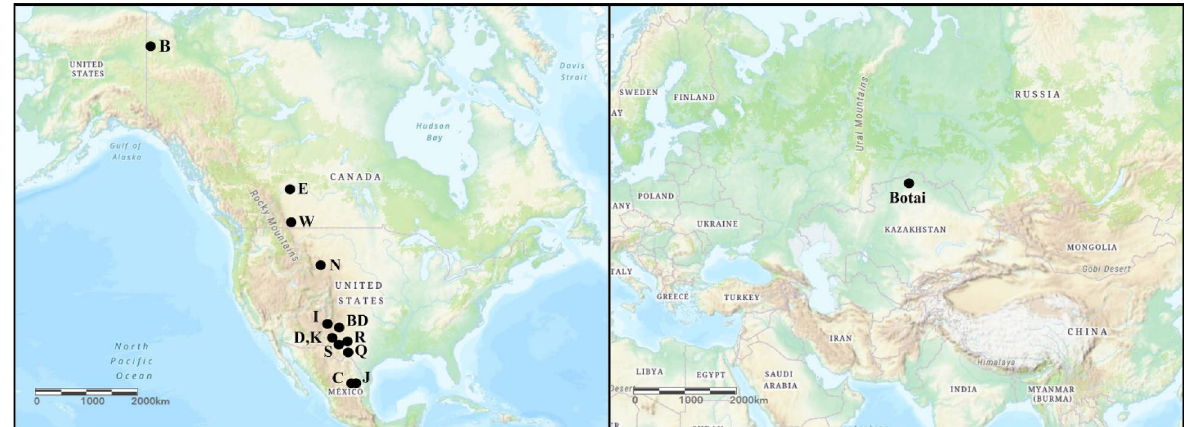
Figure 1. Geographic location of Botai (right) and North American Pleistocene sites (left). Site abbreviations: B = Bluefish Caves, BD = Blackwater Draw Loc. 1, C = Cedral, D = Dry Cave, E = Edmonton area gravel pits, I = Isleta Cave No. 2, J = San Josecito Cave, K = Dark Canyon Cave, N = Natural Trap Cave, Q = Cueva Quebrada, R = Scharbauer Ranch, S = Salt Creek, W = Wally’s Beach. This map was generated using the open- source software qGIS (https:// www. qgis. org/ en/ site/), version